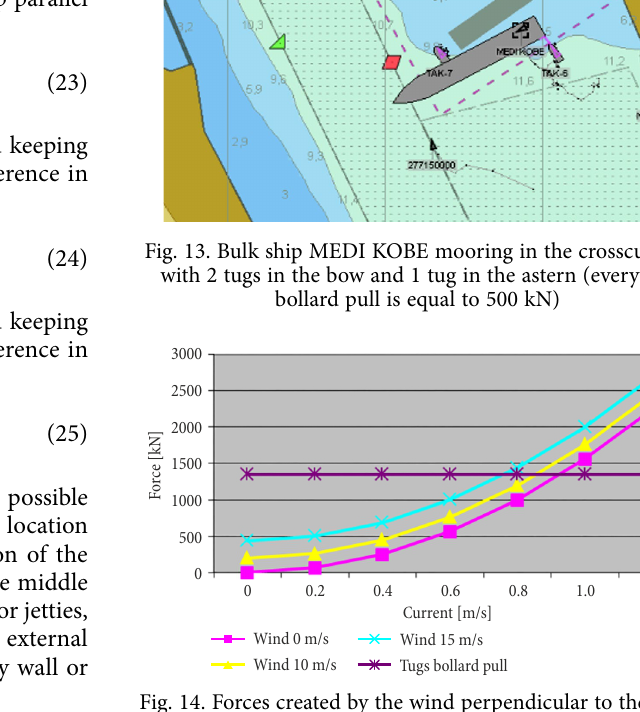
Fig. 14. Forces created by the wind perpendicular to the ship, the current acting at an angle of 70° to the ship’s hull and 3 tug bollard pulls (each tug has the capacity of 500 kN bollard pull) received by the classical ship theory